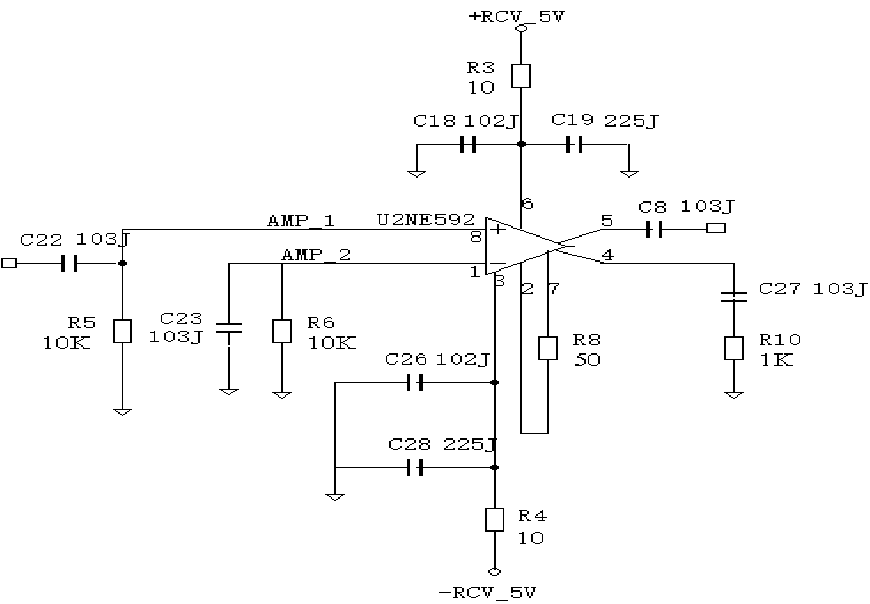
Figure 5. Modified circuit of the TIA from Figure 4.